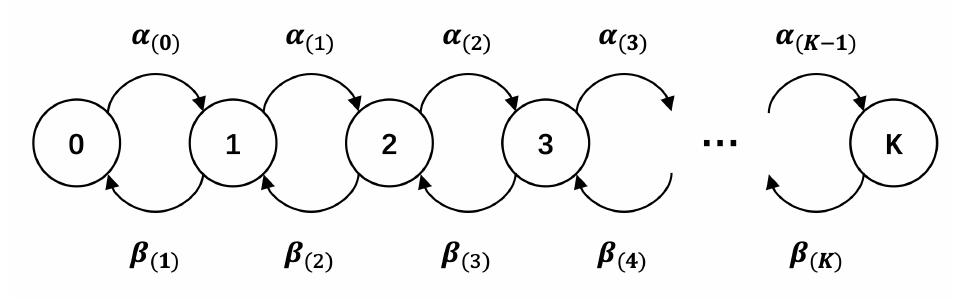
Figure 2. The state transition diagram with a high-demand